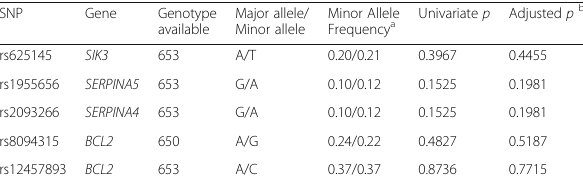
Table 17 (abstract A26). Associations in univariate and multivariate analysis between SNPs and AKI